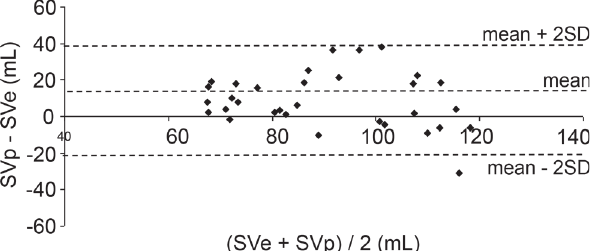
Fig 5. Bland-Altman plots for determination of agreement between SVe and SVp computed with the systolic area method. —— : limits of agreement (maximum, minimum, mean).